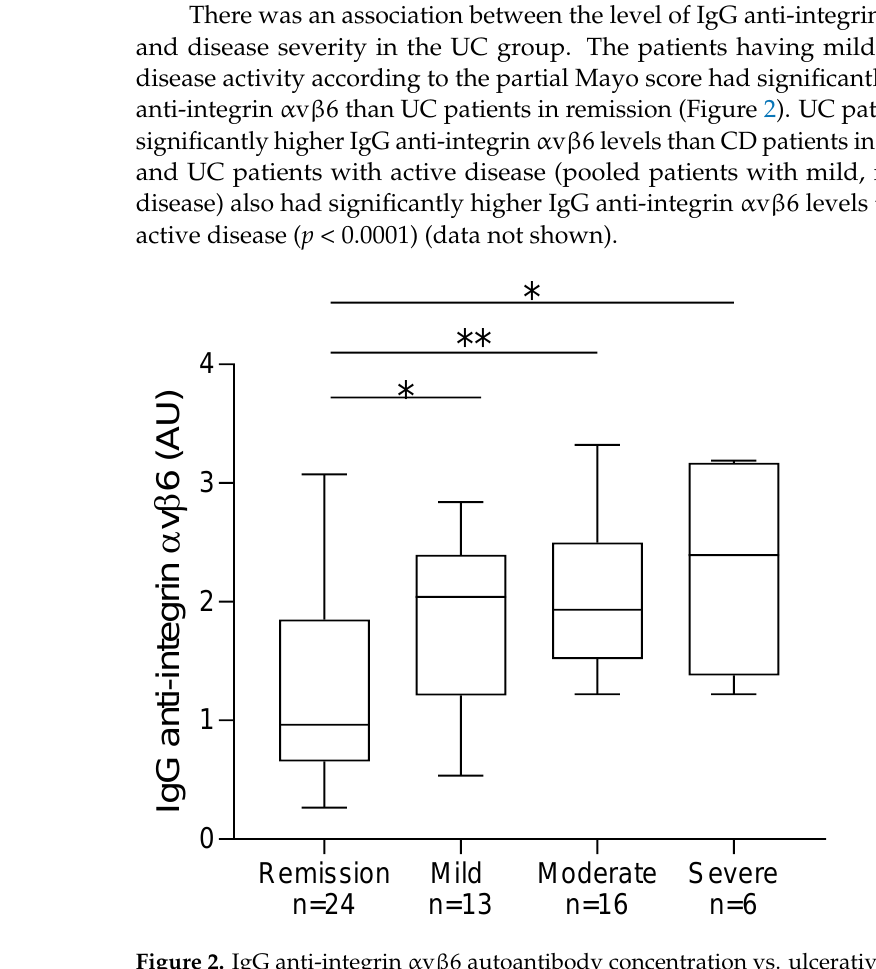
Figure 2. IgG anti-integrin α v β 6 autoantibody concentration vs. ulcerative colitis disease severity according to the partial Mayo score. Significant differences between the severity groups are indicated (* p < 0.05, ** p < 0.01).